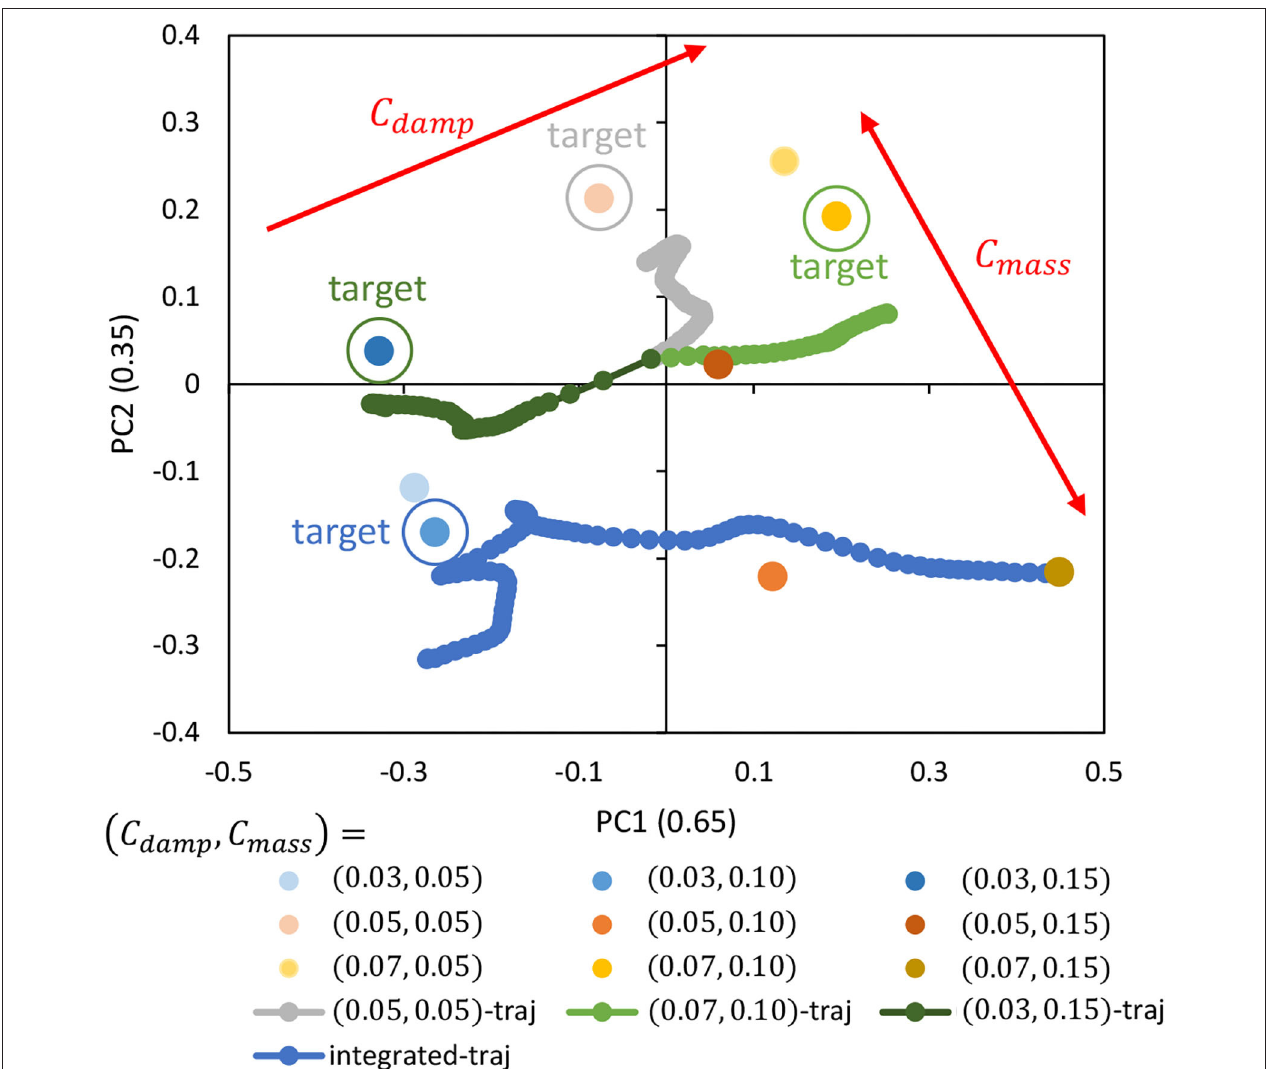
FIGURE 5 | Simulation experiment: the trained parametric bias when setting C damp = { 0.03,0.05,0.07 } and C mass = { 0.05,0.10,0.15 } , the trajectory of online updated parametric bias when setting ( C damp , C mass ) = { (0.05,0.05),(0.07,0.10),(0.03,0.15) } , and the trajectory of online updated parametric bias when setting ( C damp , C mass ) = (0.03,0.10) for the integrated